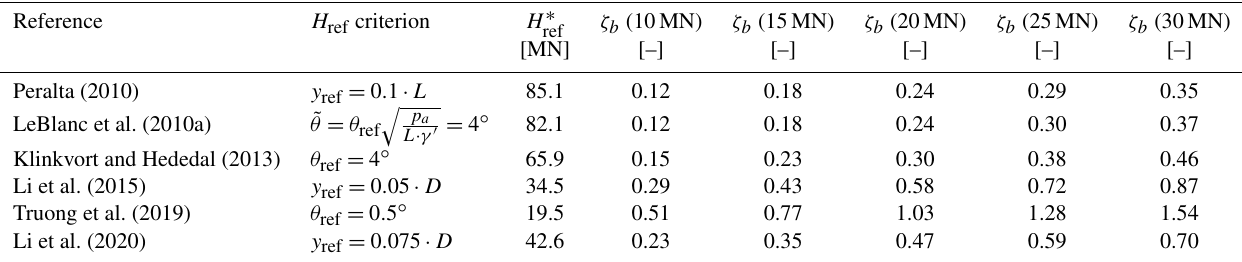
Table 2. Different criteria for the definition of the reference horizontal load ( H ref ) and corresponding values determined from Fig. 1 with relative load magnitudes ( ζ b ) for selected values of H max